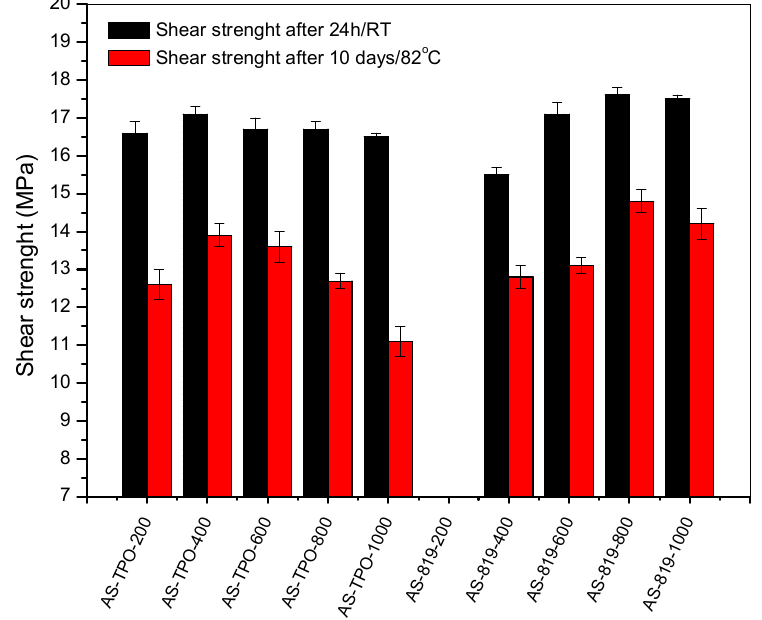
Figure 5. Shear strength of thermally cured aluminum–SAT–aluminum overlap